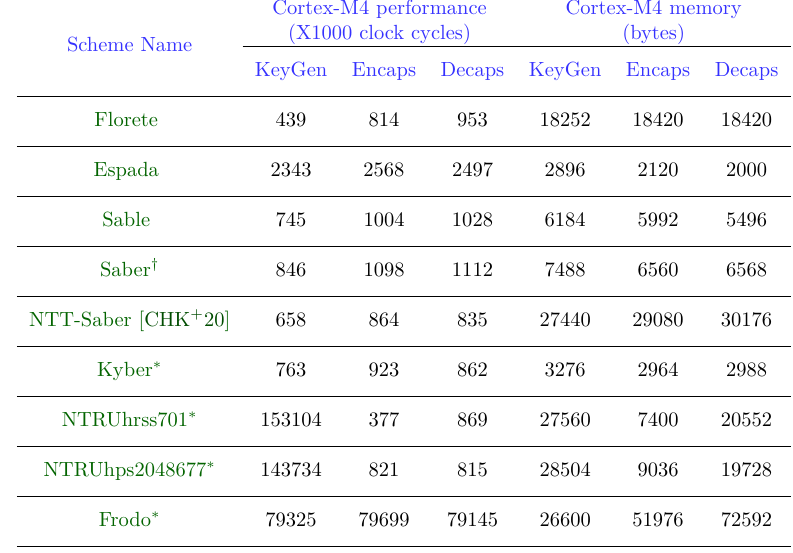
Table 4: Comparison Scabbard with NIST finalist KEMs on Cortex-M4 for security level 3 ∗ Collected from pqm4 [KRSS] † Collected from the official website of Saber for high-speed